Question: Author a descriptive caption for the visualization shown.
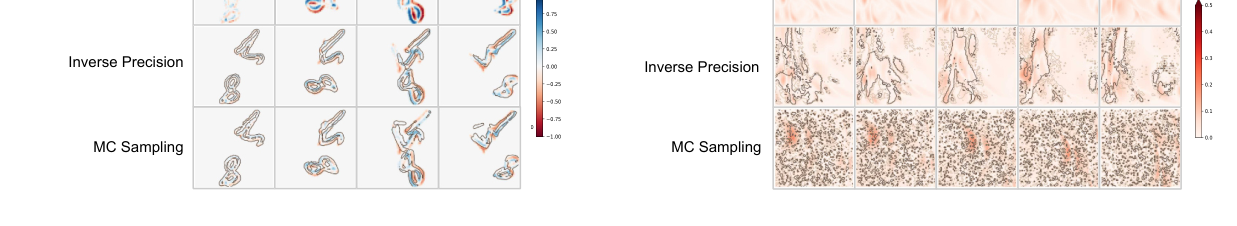
Answer: Predictions and inverse precision of CogDPM on rigid-body MovingMNIST dataset (left) and Turbulence flow dataset (right).